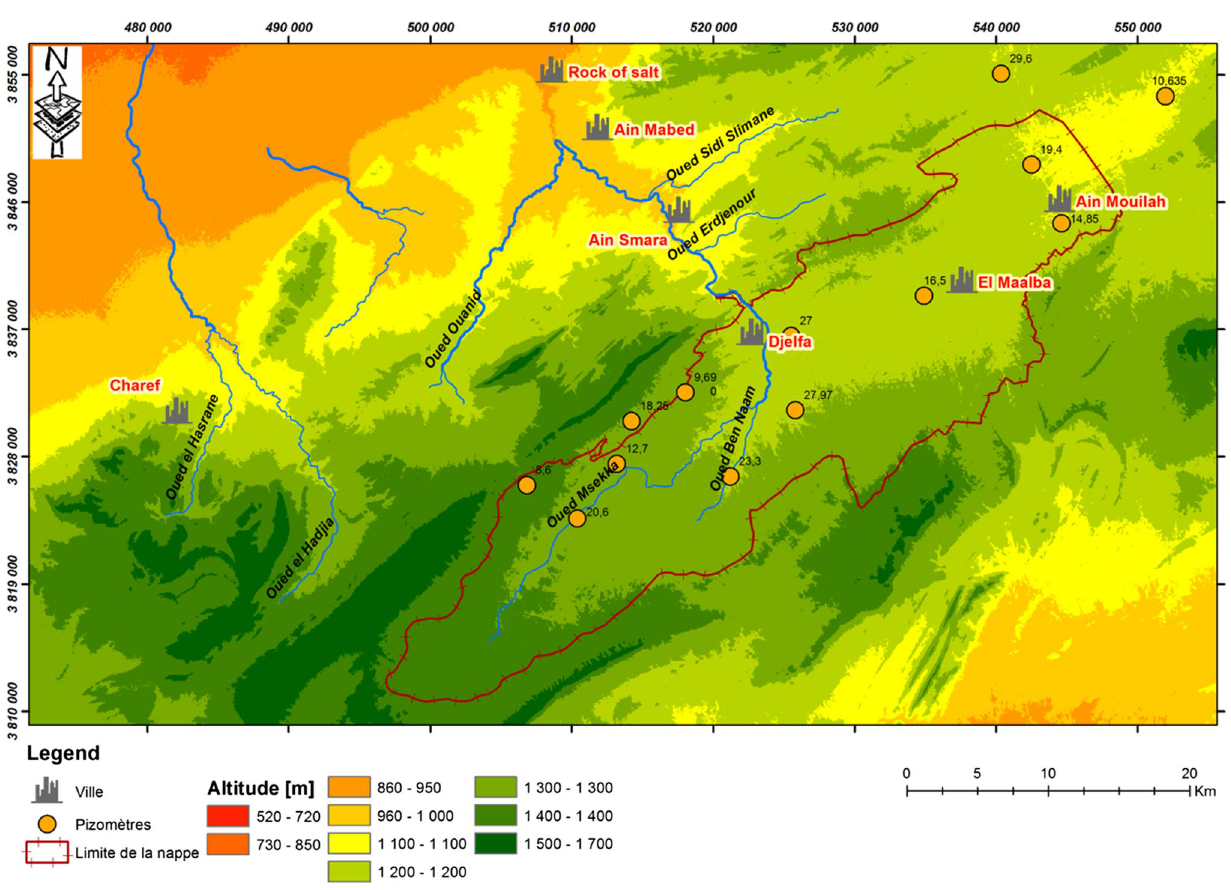
Fig. 2 Study area (watershed of Djelfa-Melah